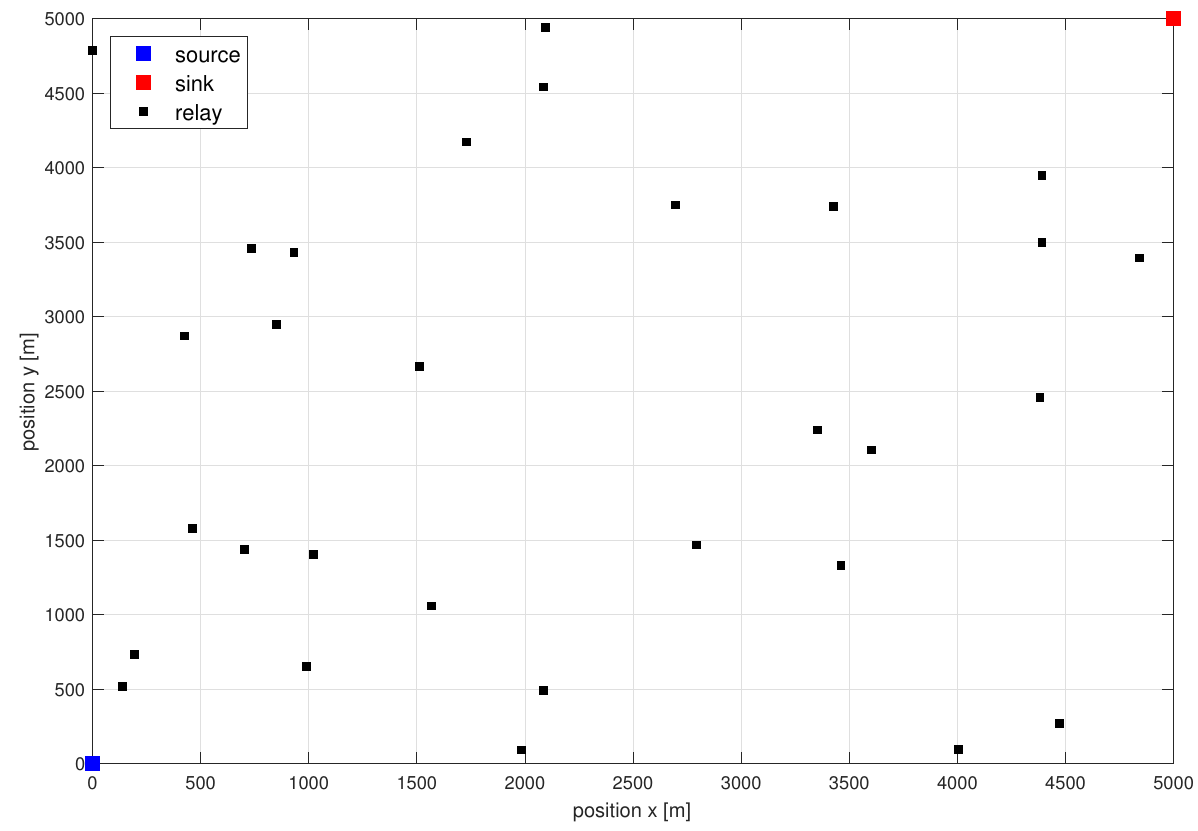
Figure 2. Example of the network topology with 30 relays, for area width of 5